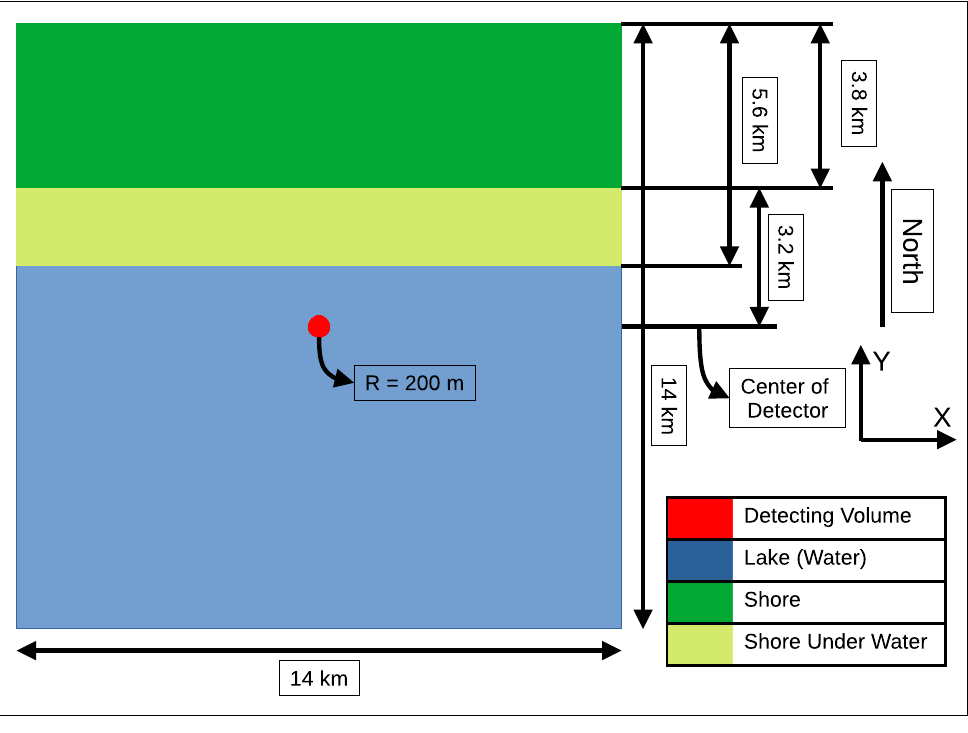
Figure 2. XY view of the schematics of the geometry used in the simulation.